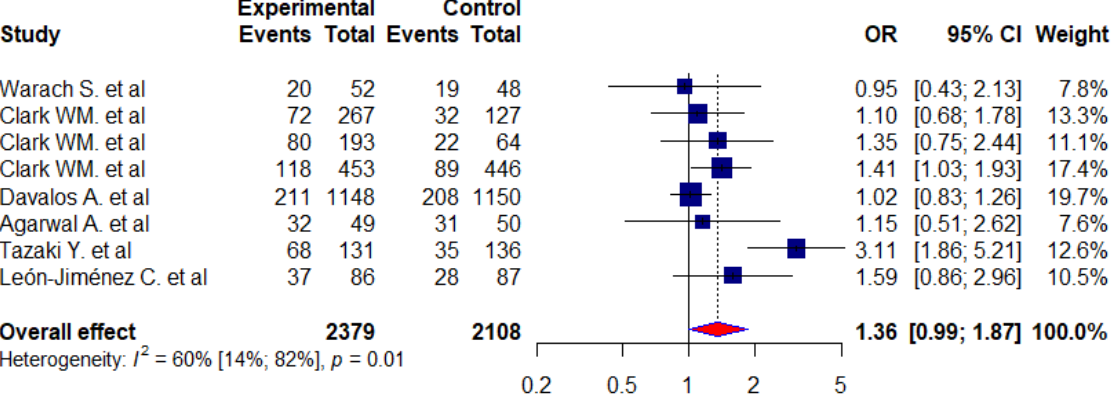
Figure 3. The forest plot of treatment e ff ect of citicoline on functional recovery (using mRS < 1).